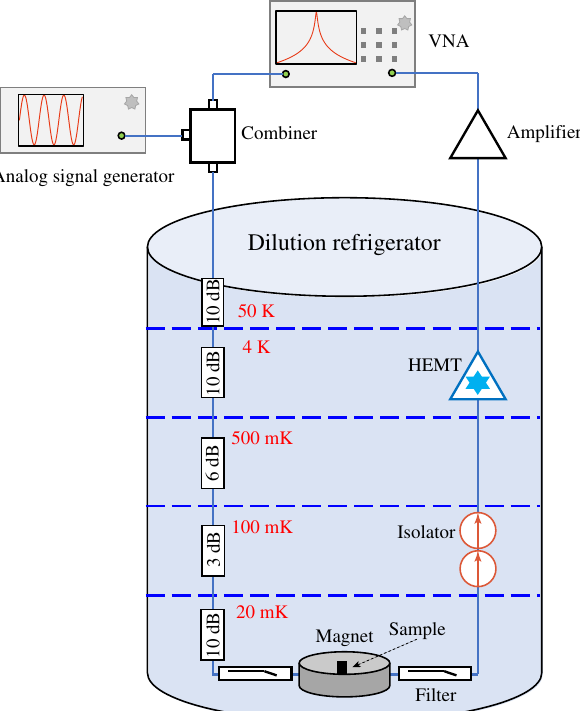
FIG. 5. A schematic of the experimental setup, where the hybrid system in Fig. 1(a) is placed in a cryogenic